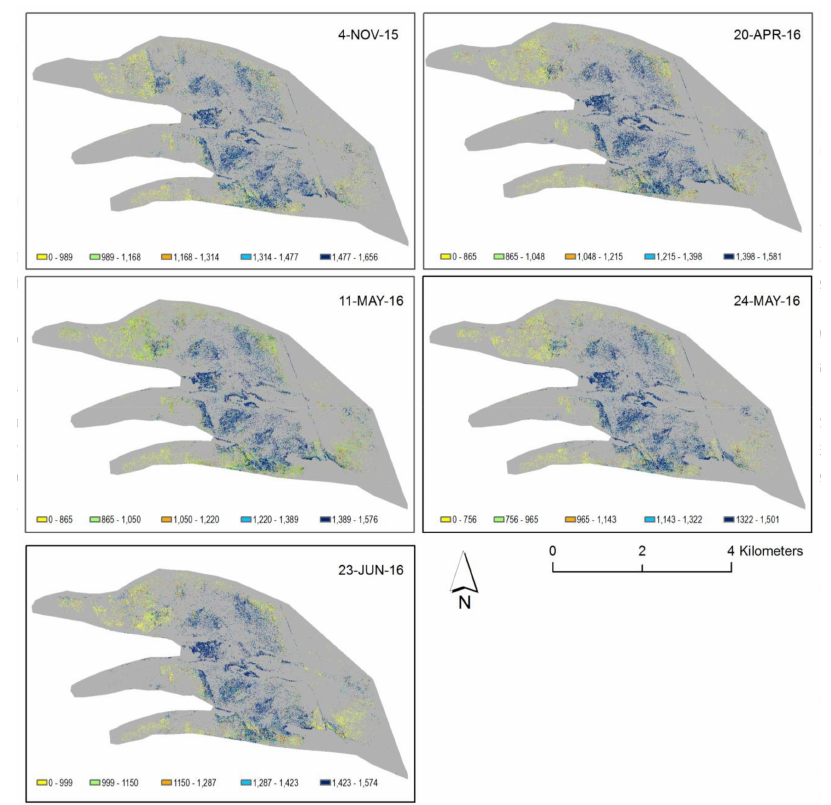
Figure 8. Spatial pattern of gravimetric water content (GWC%) in hollows at the Mer Bleue peatland for five dates between 4 November 2015 and 23 June 2016. The bins represent the natural breaks based on 5 classes; therefore, the range of each class differs slightly by